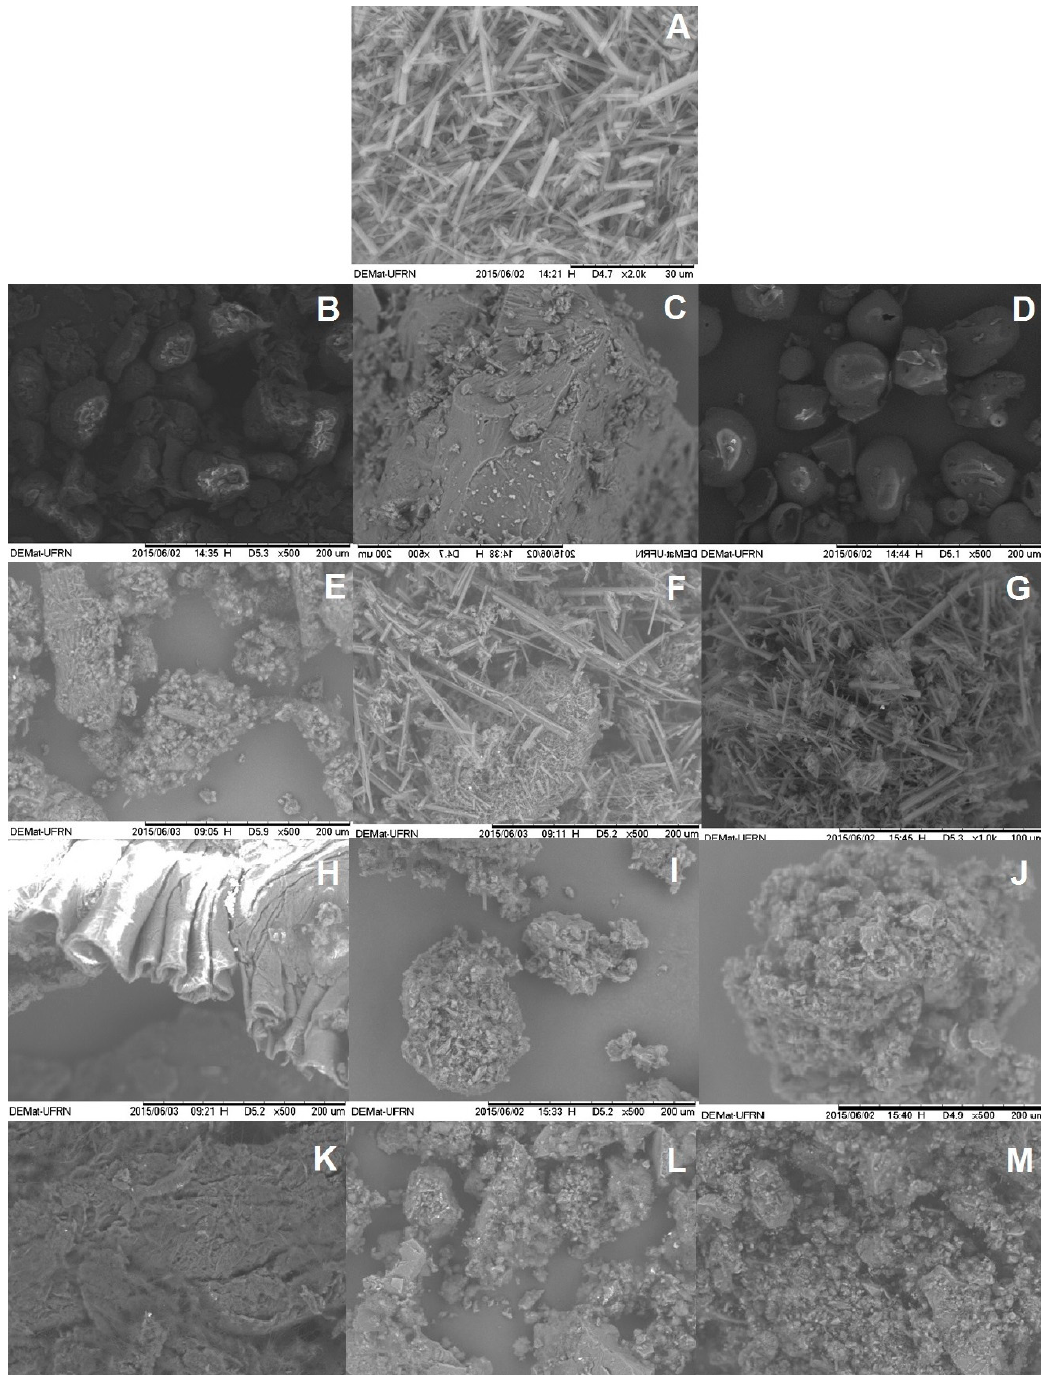
Figure 2. SEM micrographs of ABAM ( A ), HPMC ( B ) PEG-6000 ( C ), PVP K-30 ( D ), PMs of ABAM and HPMC ( E ), ABAM and PEG 6000 ( F ) and ABAM and PVP K-30 (G ). SDs prepared by KND of ABAM and HPMC ( H ), ABAM and PEG 6000 ( I ) and ABAM and PVP K-30 ( J ). SDs prepared by RE of ABAM and HPMC ( K ), ABAM and PEG 6000 ( L ) and ABAM and PVP K-30 ( M ).